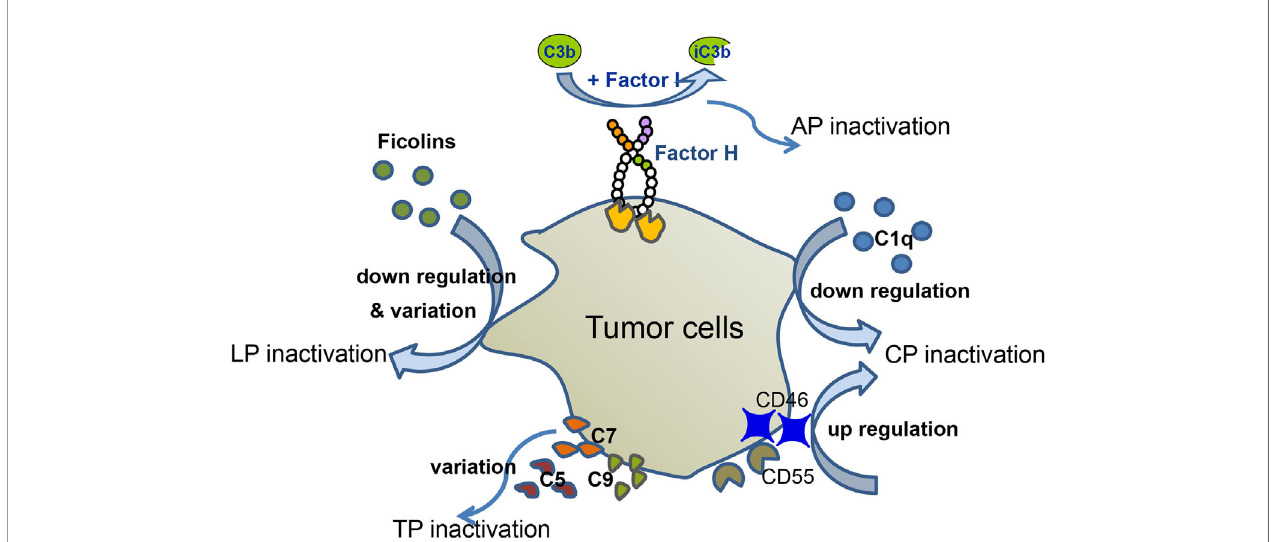
FIGURE 2 | Complement evasion of hematological malignancies. Different types of hematological malignancies utilize different strategies for complement evasion. In MM patients, serum levels of C1q are down-regulated, which mediates CP inactivation. MM cells recruit Factor H to their surface, thereby down-regulating AP activation. Up-regulation of CD46 and CD55 inhibits complement activation. Down-regulation and variation of fi colin1, 2 lead to LP inactivation. In CLL patients, tumor cells altered C5 pattern to modify CP activation. Variation of C9 correlates with EFS of FL, and variation of C7 correlates with EFS of